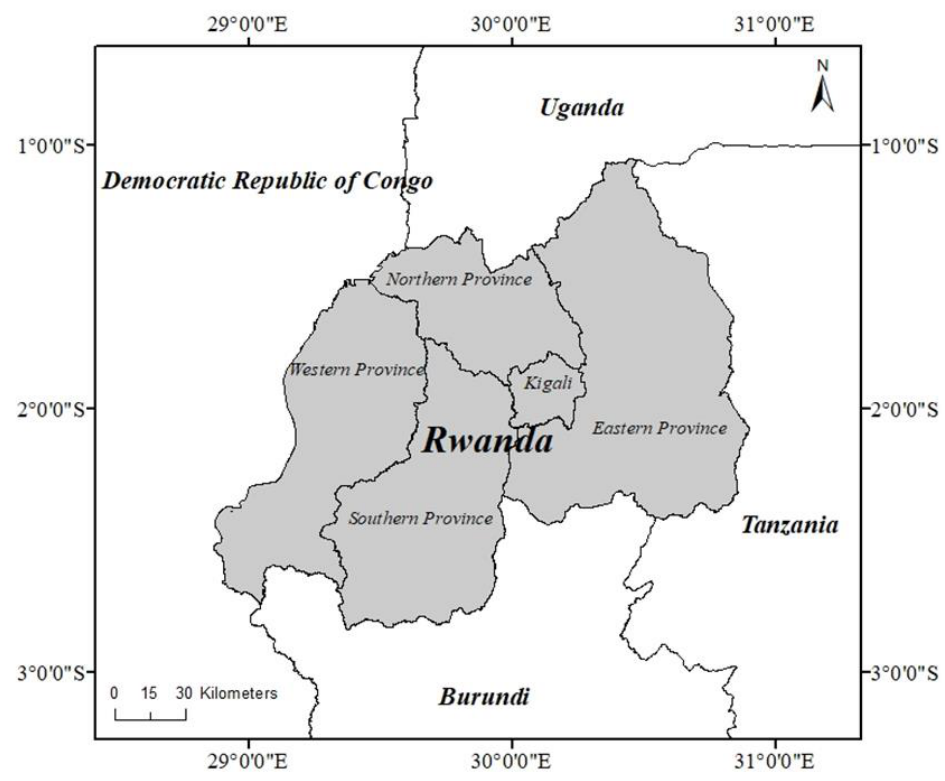
Figure 1. The administrative map of Rwanda, including its four provinces, Kigali, and neighboring countries.